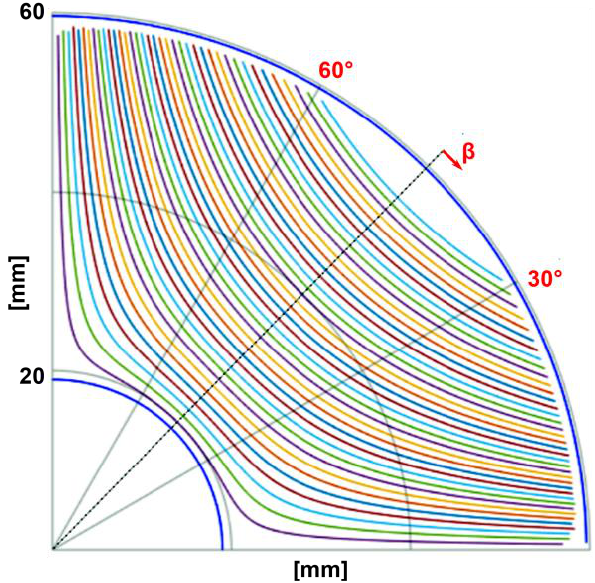
Figure 1. Flux analytical distribution inside the rotor considered in this work.